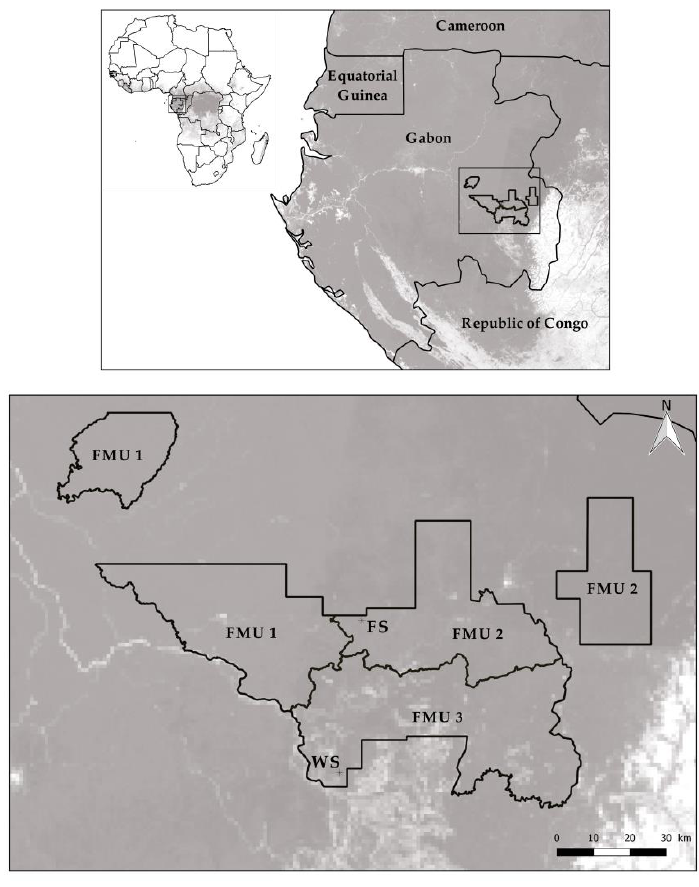
Figure 1. Location of the enrichment plantings in a logging concession in Gabon (black stars); FS: fertilizer study and WS: wildlife study. The background map corresponds to the tree cover (grey) [25].